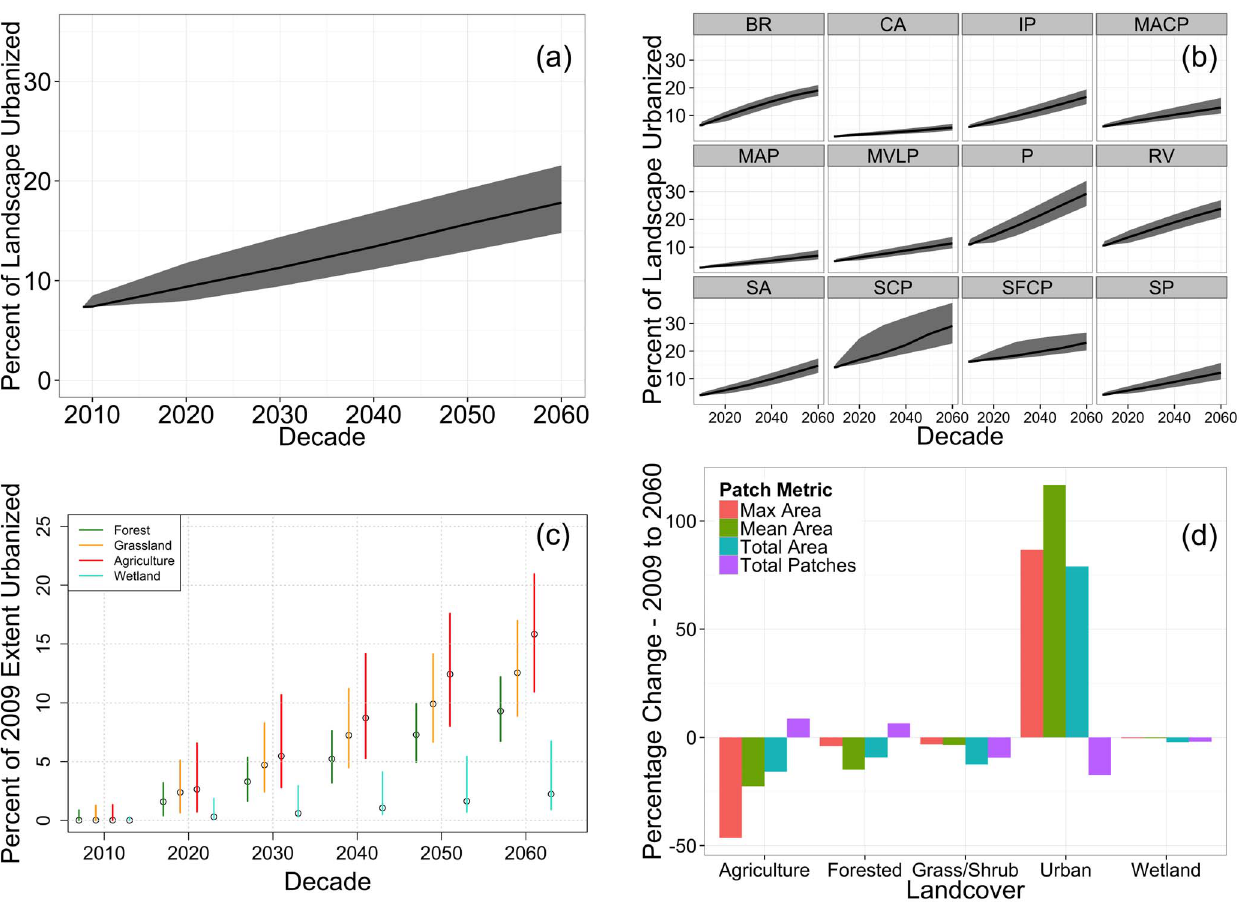
Figure 3. Land cover change metrics. (a) and (b) show time series of projected urbanization for 200 model simulations for the study region and twelve ecoregions, respectively. (c) The 95% projected range of the proportion of each land cover type converted to urban. (d) Change in patch metrics for all land cover types between 2009 and 2060. Ecoregion abbreviations in (b) are as follows: BR – Blue Ridge, CA – Central Appalachians, IP – Interior Plateau, MACP – Mid Atlantic Coastal Plain, MAP – Mississippi Alluvial Plain, MVLP – Miss. Valley Loess Plains, P – Piedmont, RV – Ridge and Valley, SP – Southeastern Plains, SCP – Southern Coastal Plains, SFC – South Florida Coastal Plain, SA – Southwest Appalachian.